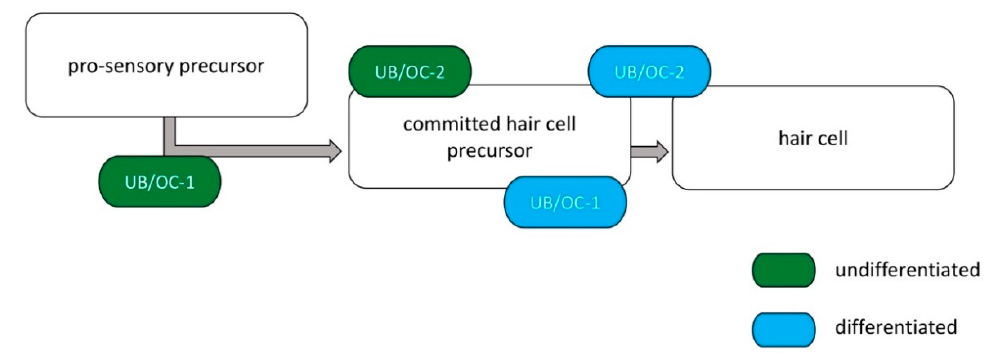
Figure 8. Developmental stages of immortalized hair cells depending on the degree of differen- tiation. In the undifferentiated state, the UB/OC − 1 are at the stage of a pro-sensory progenitor, while the UB/OC − 2 cells exhibit early characteristics of committed hair cell precursor cells. After differentiation, UB/OC − 1 cells are in the process of differentiating into hair cells. The UB/OC − 2 are at the stage of solid hair cells. The scheme is based on the model of Rivolta et al. 1998 [34].